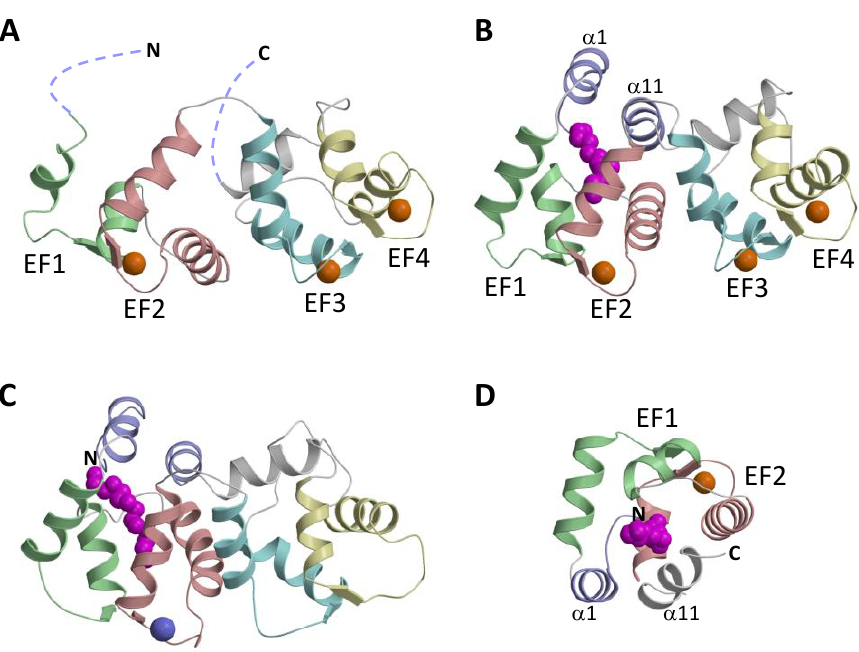
Figure 2. Atomic-level structures of unmyristoylated GCAP2 ( A ), myristoylated GCAP1 ( B ), Mg 2+ - bound GCAP1 V77E ( C ), and myristoyl group binding site in Ca 2+ -bound GCAP1 ( D ). The color scheme is the same as in Figure 1. The EF-hands are shaded green, red, cyan, and yellow. The terminal helices ( α 1 and α 11) that contact the myristoyl group are colored purple. Bound Mg 2+ and Ca 2+ are colored purple and orange, respectively. The N-terminal myristoyl group is colored ma- genta.